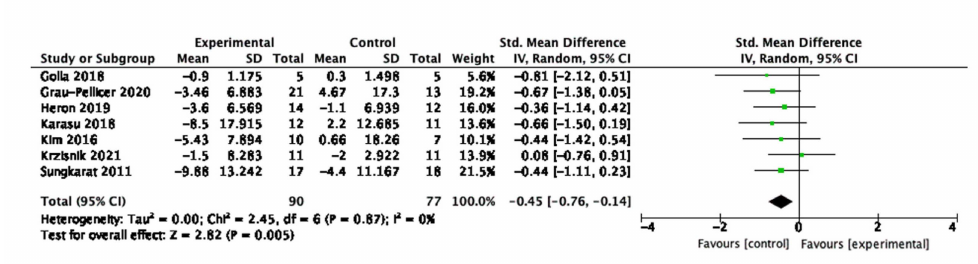
Figure 8. Subgroup analysis for the timed up and go